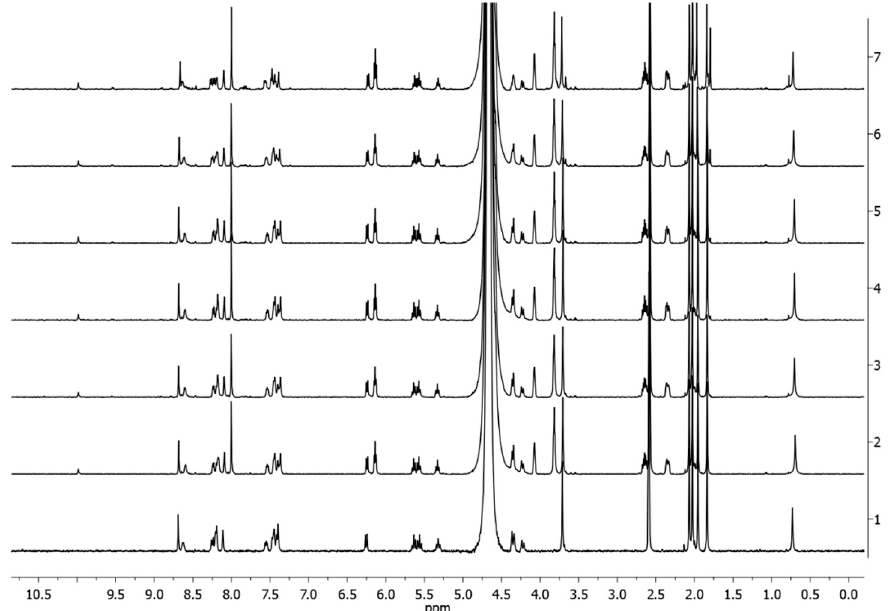
Figure 11. 1 H-NMR spectra over time of 2Pt-im in 9:1 v/v PB:DMSO- d 6 (trace 1) and in the presence of 2.5 eq. of dGMP at 37 °C (trace 2 = start, 3 = 2 h, 4 = 4 h, 5 = 6 h, 6 = 24 h, 7 = 48 h). After 48 h, no coordination of dGMP to the platinum center was observed, while traces to the complex 4Pt–DMSO were found. Such results were also confirmed by ESI mass spectrometry experiments performed in 9:1 v/v H 2 O:DMSO. The analysis of the reaction mixture at t = 0 (Figure 12A) and after 48 h of incubation at 37 °C (Figure 12B) confirmed the lack of coordination by dGMP and the formation of the 4Pt-DMSO complex. Analog results were obtained for the 4Pt-py complex (Figure S19).